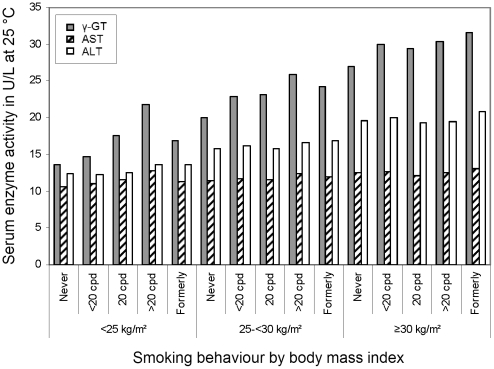
Geometric mean serum activities of γ-GT (grey bars), AST (hatched bars) and ALT (white bars; all in U/L measured at 25°C) in 15,281 men in Germany, by body mass index and smoking behaviour (cpd = cigarettes per day).